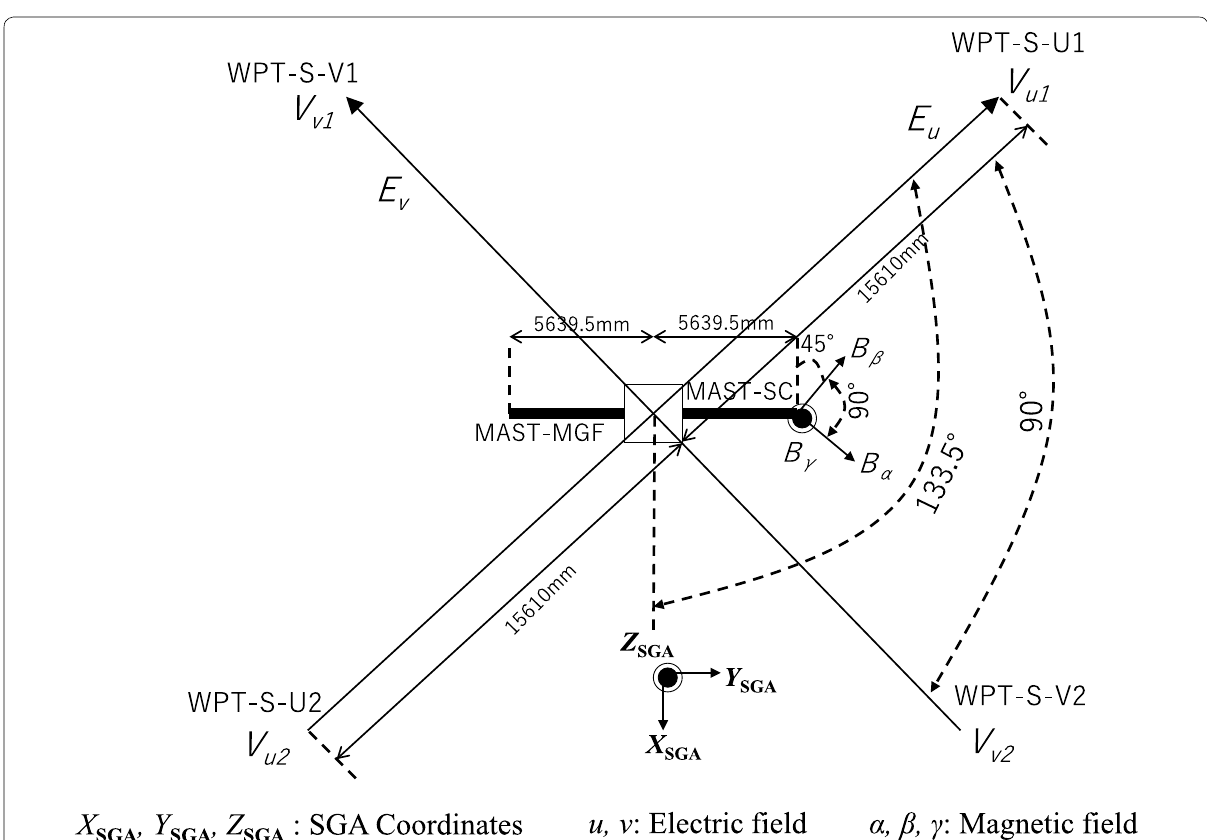
Fig. 3 Configuration of the PWE sensors deployed from the Arase satellite. The SGA coordinates are represented by X , Y , Z . The WPT is radially deployed and directed in the u and v directions, and the coordinate systems for the MSC are defined by the symbols ( α , β, γ ± ±